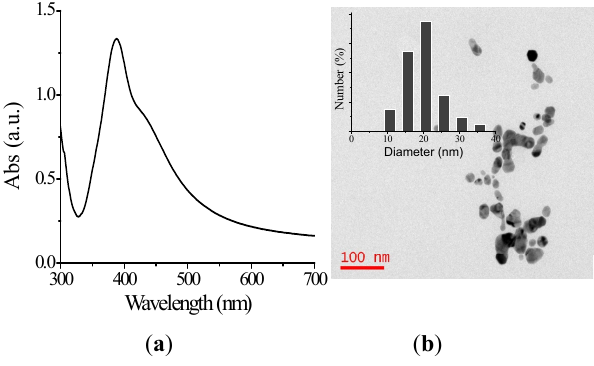
Figure 3. The UV-Vis absorption spectrum ( a ) and the HRTEM image ( b ) of AgNPs. The inset is their statistic diameters.